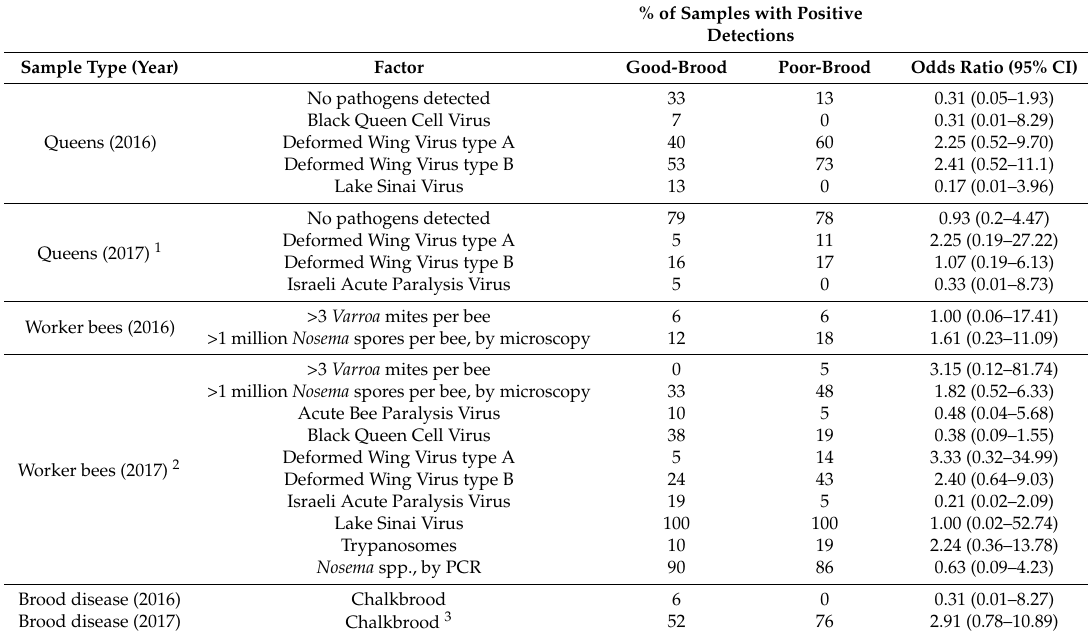
Table 2. Summary of the odds ratios (95% CI range) and the percent of positive pathogen detections using PCR for worker bee samples (5 g composite sample) in 2017 and queen samples in 2016 and 2017 from colonies with good-brood or poor-brood patterns. Only pathogens with positive detections are included; chronic bee paralysis virus was not found in any samples. Also included are the comparisons between poor-brood and good-brood colonies with symptoms of the brood disease chalkbrood, and worker bee samples with Varroa destructor mite levels >3 mites per 100 bees, and Nosema spp. levels >1 million spores per bee as determined by microscopy. No pathogen had significantly higher odds of being in a poor-brood pattern colony or